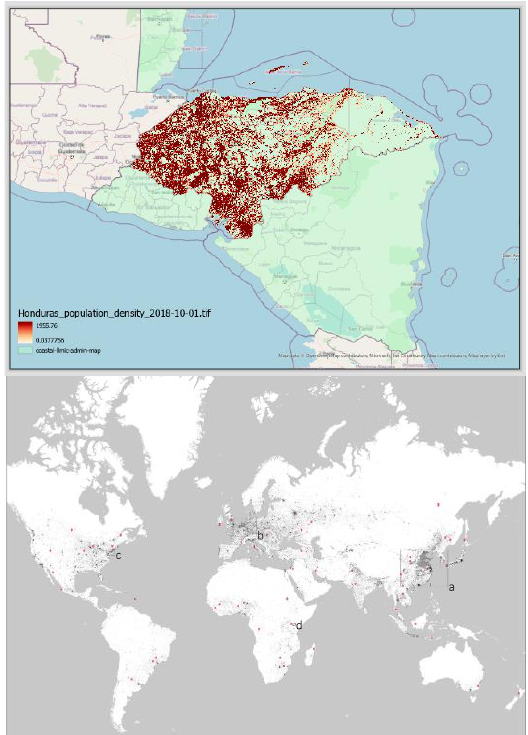
Figure 7 . High-Resolution Settlement Layer (HRSL) 2020 (Facebook - CIESIN 2016) and World Settlement Footprint 2015 (Marconcini et al., 2020)